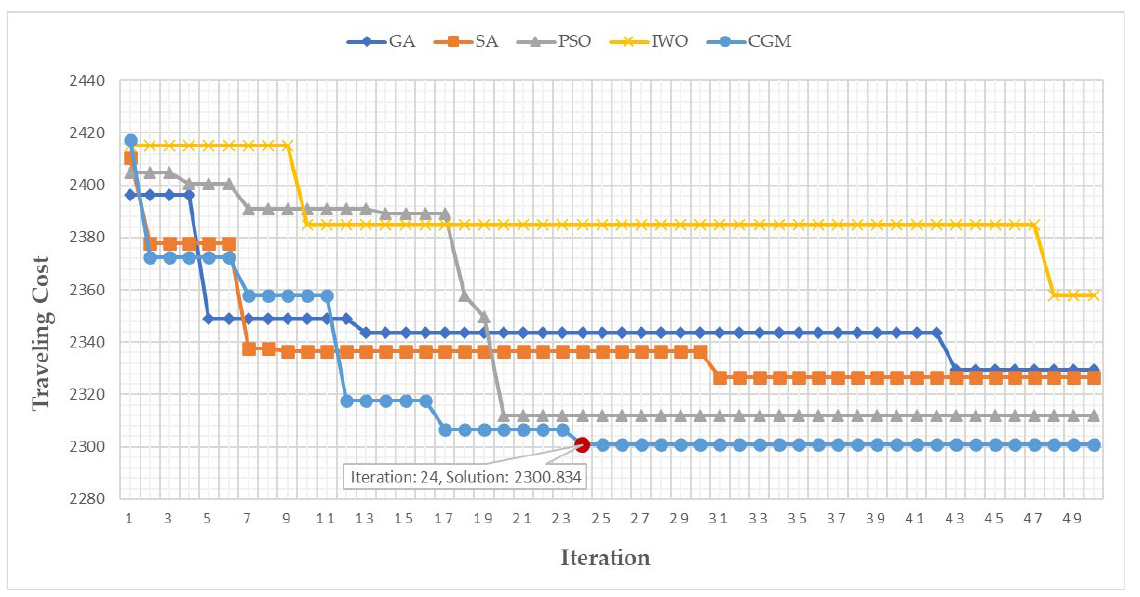
Figure 11. Investigation of convergence in different algorithms for the traveling salesman problem (the number of cities was 500).